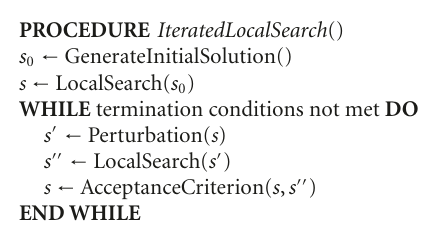
Algorithm 1: Pseudocode of an iterated local search